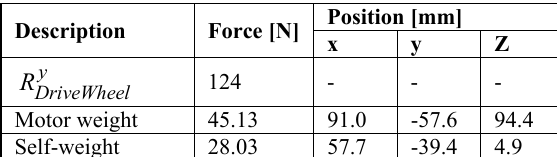
Figure 17. Movement restriction of the drive wheel structure Table 4. Position and values of applied loads to the